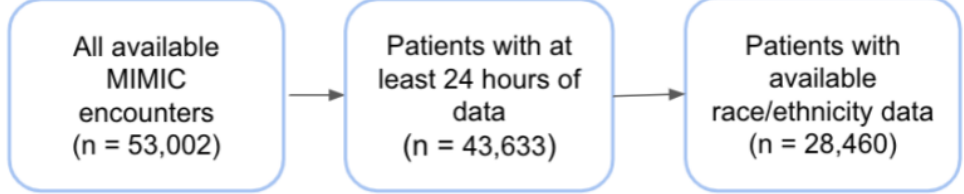
Figure 1. Attrition diagram for patient